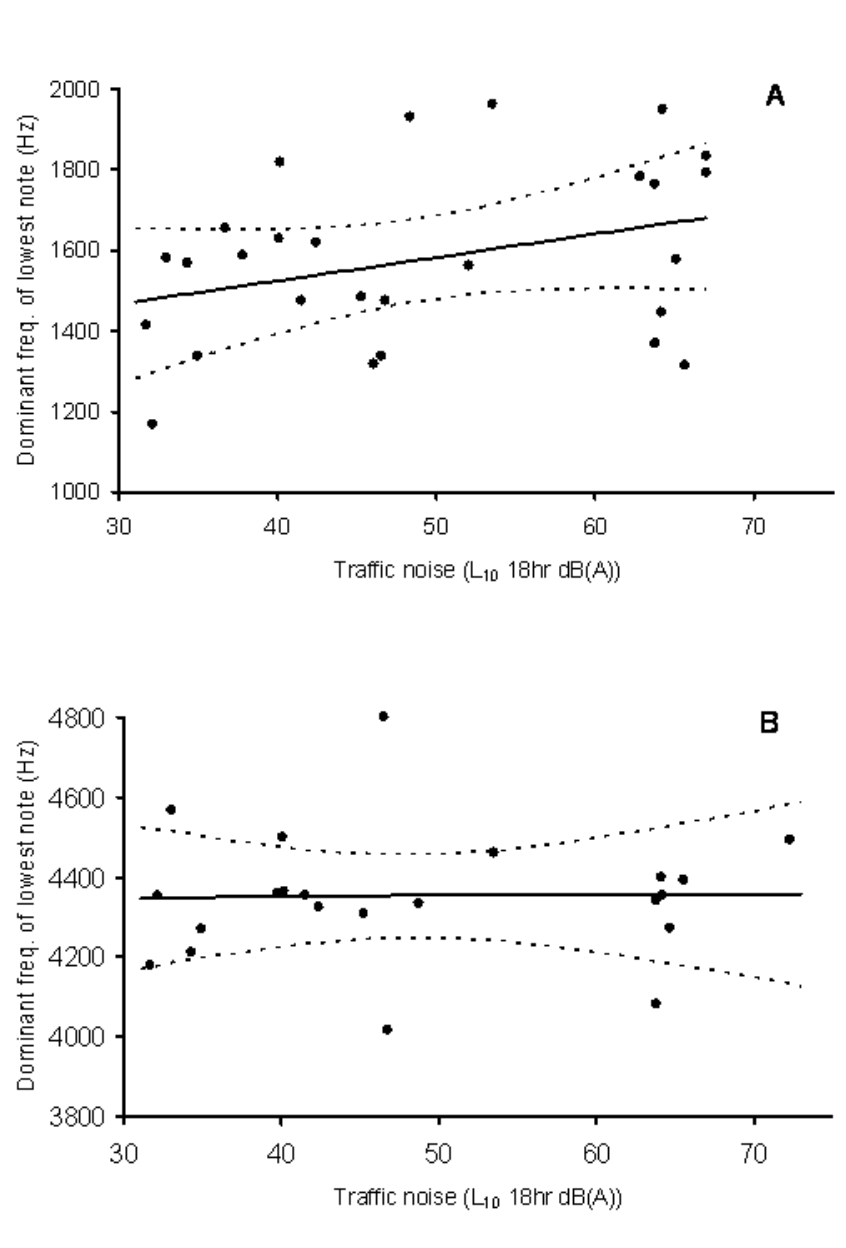
Fig. 3. The effect of traffic noise on the frequency of bird song (dominant frequency of the lowest tonal note). (A) Song of the Grey Shrike-thrush ( n = 27); (B) song of the Grey Fantail ( n = 22). Solid lines show the predicted relationships, dashed lines the 95% credible intervals, and circles the mean song frequency observed at each